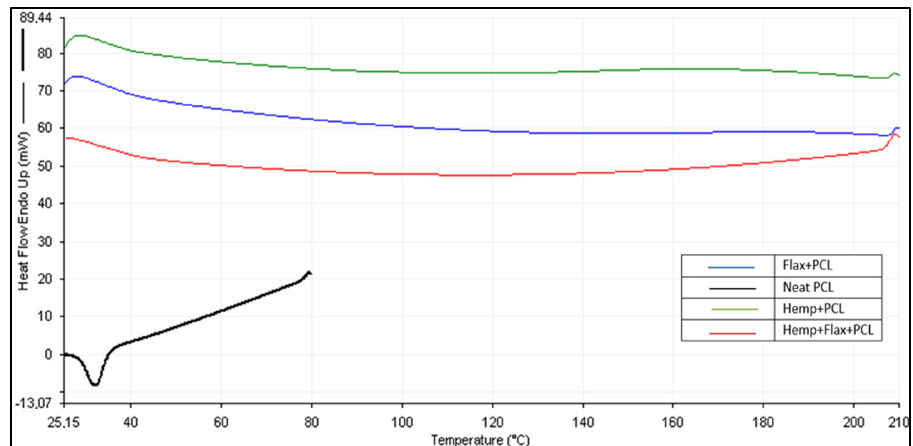
Figure 10. DSC curves representing Tc of different samples.